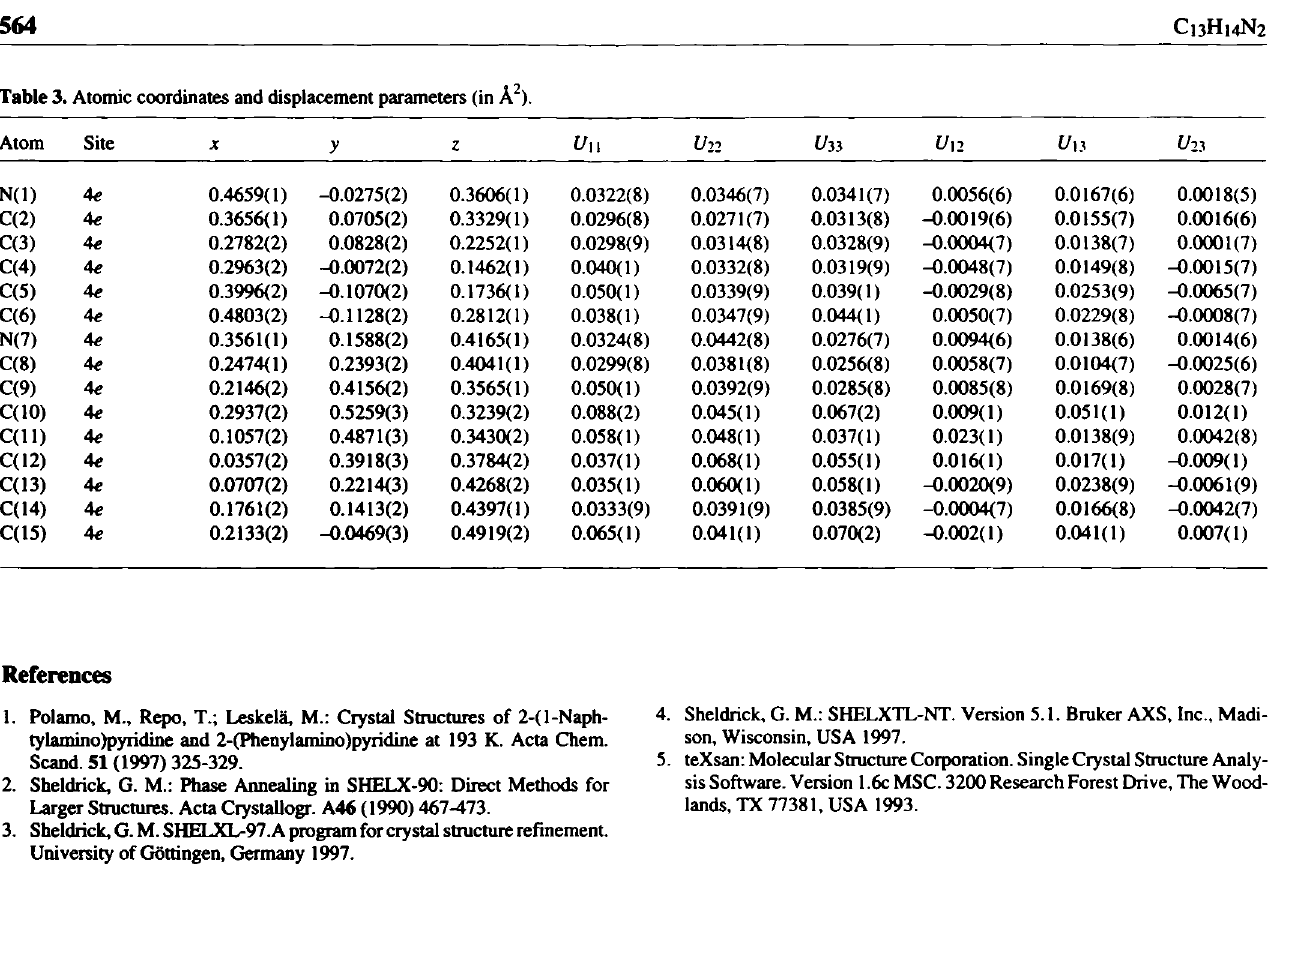
Table 3. Atomic coordinates and displacement parameters (in Â 2